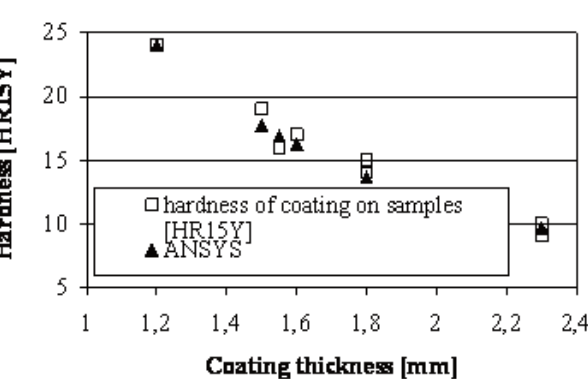
Fig. 10. Comparison between measured and computed hard- ness.